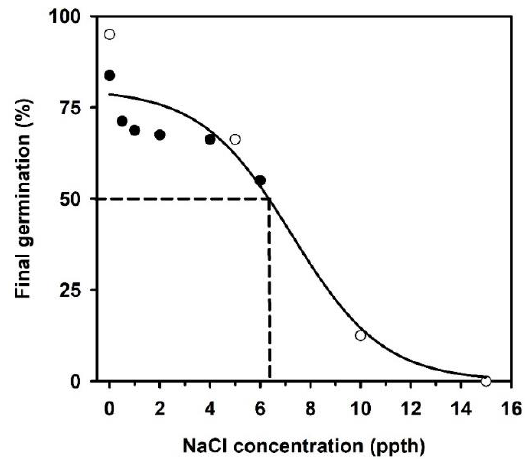
Figure 4. Relationships between Linum arenicola germination and NaCl concentration. Dotted line